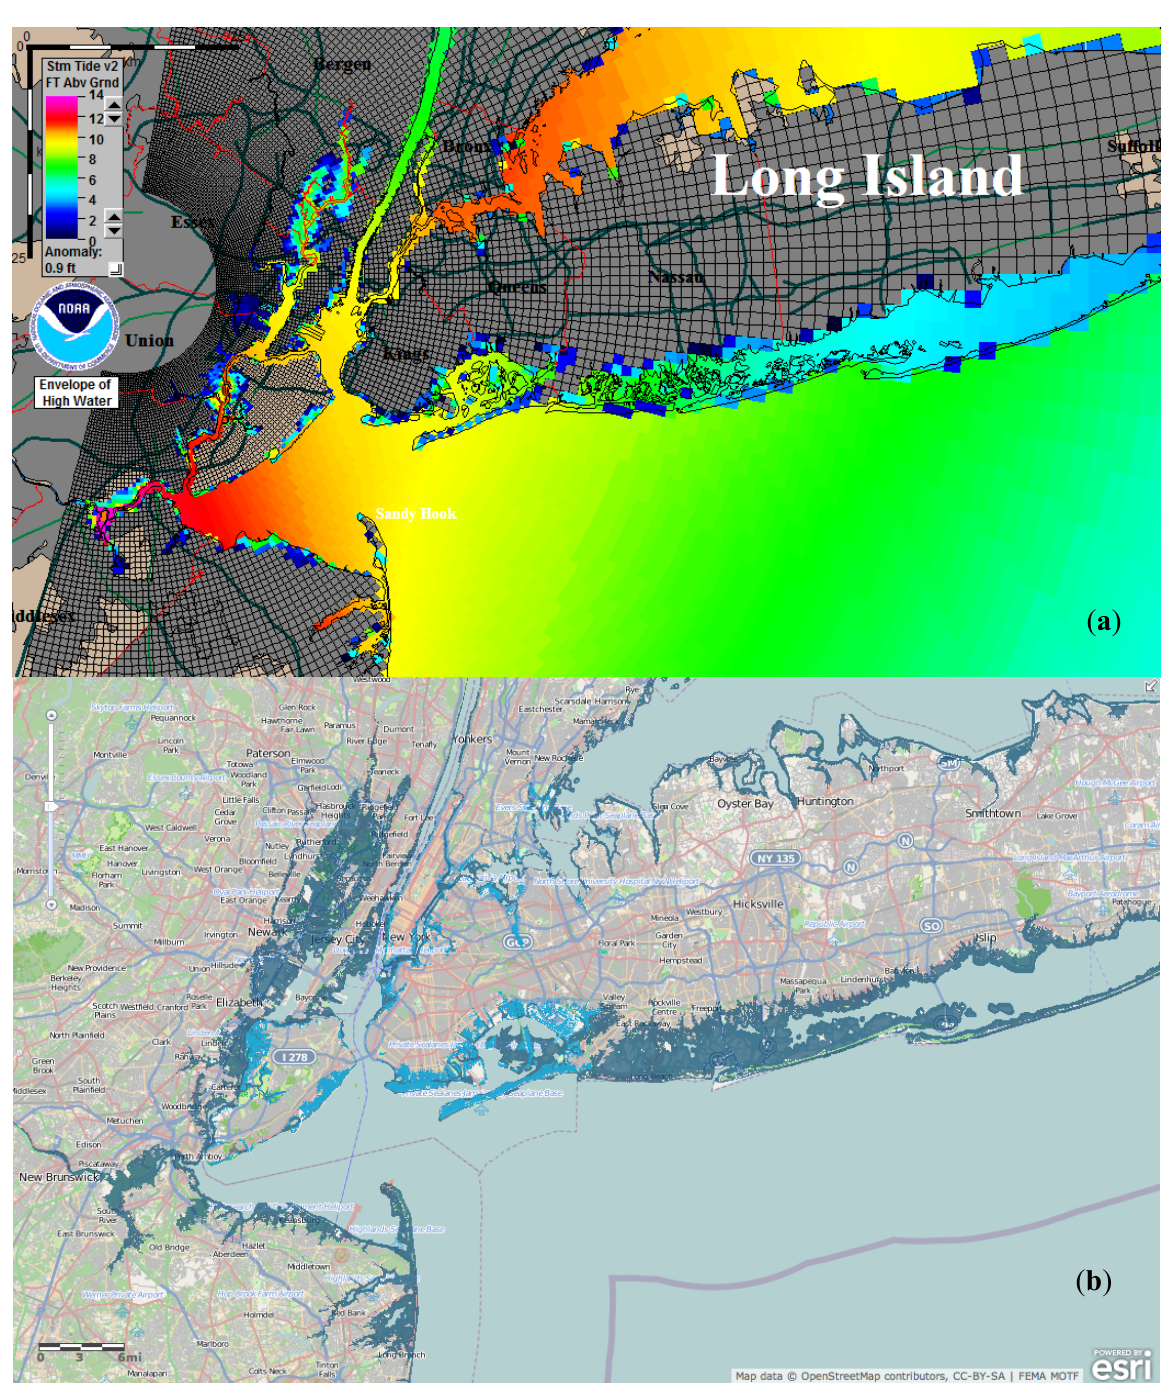
Figure 18. ( a ) SLOSH model-simulated inundation (ft) above ground level (AGL) over land and maximum envelope of water over the ocean, as rendered by the interactive SLOSH Display Program; and ( b ) Modeling Task Force (MOTF) field-verified, ―ground-truth‖ Hurricane Sandy Impact Analysis graphic (courtesy of FEMA), which depicts the final high-resolution storm surge extent ( grey ) and very high-resolution extent in NYC ( blue